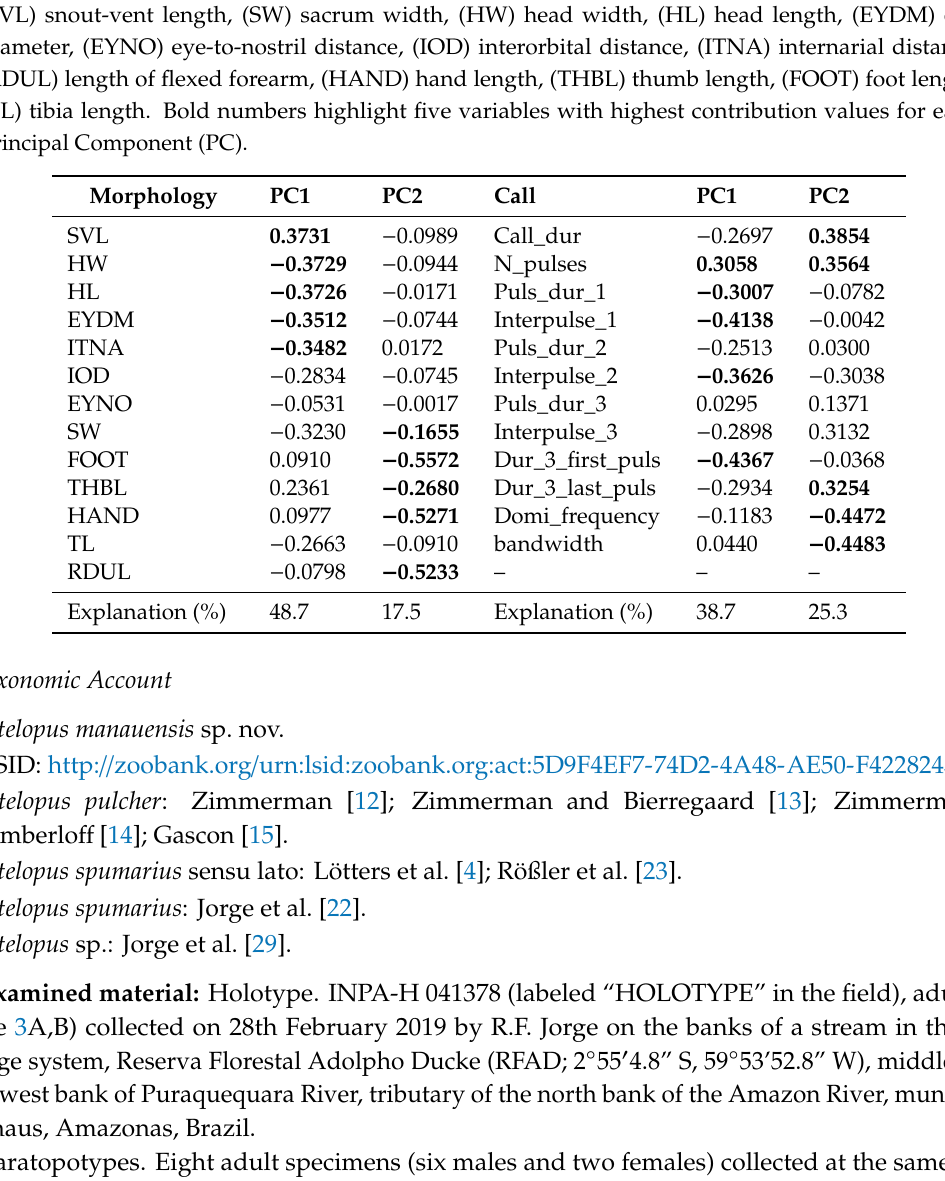
Table 3. Contribution of each variable to the first two axes of the PCAs in multidimensional morphological and acoustic spaces to explain the variation between Atelopus manauensis sp. nov. and A . hoogmoedi of REBIO Uatum ã , Pitinga River and Amap á , Brazil. The total percentage of explanation